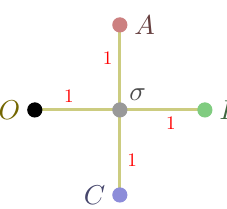
Figure 1. The graph model f G 3 which generates the extreme ray of the HEC 3 corresponding to the 4 -party perfect state. The boundary vertices are ∂V = { A, B, C, O } , and there is a single bulk vertex, σ . Our drawing conventions for this and all subsequent figures will be to use colors for the boundary vertices (black for the purifier O ), and to display all bulk vertices in